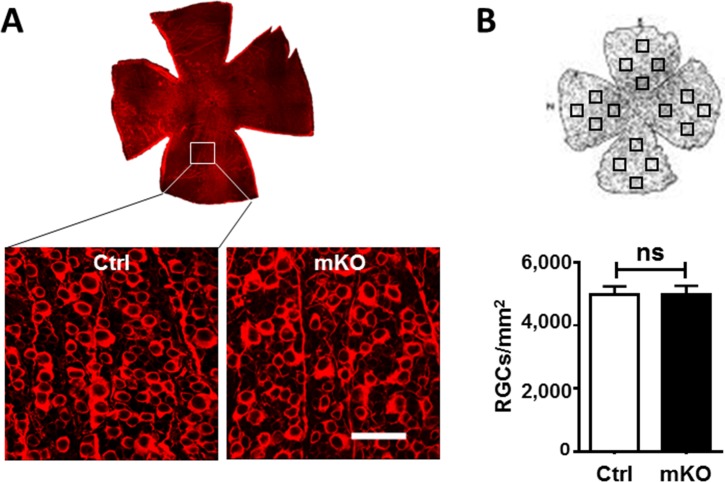
Similar RGC densities in adult mKO and littermate floxed control mice.(A) Representative en face (top) and β-III-tubulin-immunolabeled retinal flat-mounts taken from littermate floxed control and mKO mice; scale bar: 50 μm. (B,C) Schematic illustration of RGC quantification (B) and RGC densities in adult littmate floxed and mKO mice (C; n = 6/group). No significant difference (NS) was noted between the floxed and mKO mice (P = 0.98; two-tailed student t test).